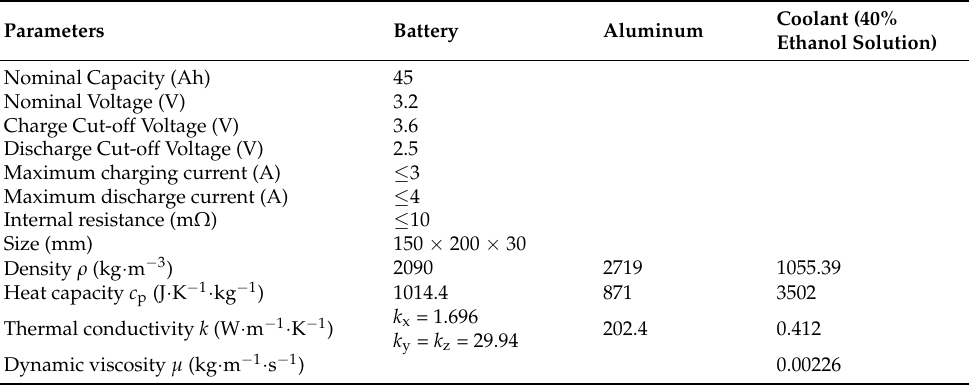
Figure 1. The diagram showing the structure and components of the BTMS for the lithium-ion battery. Table 1. Main performance parameters and thermo-physical properties of the battery, coolant, and cold plate explored in this